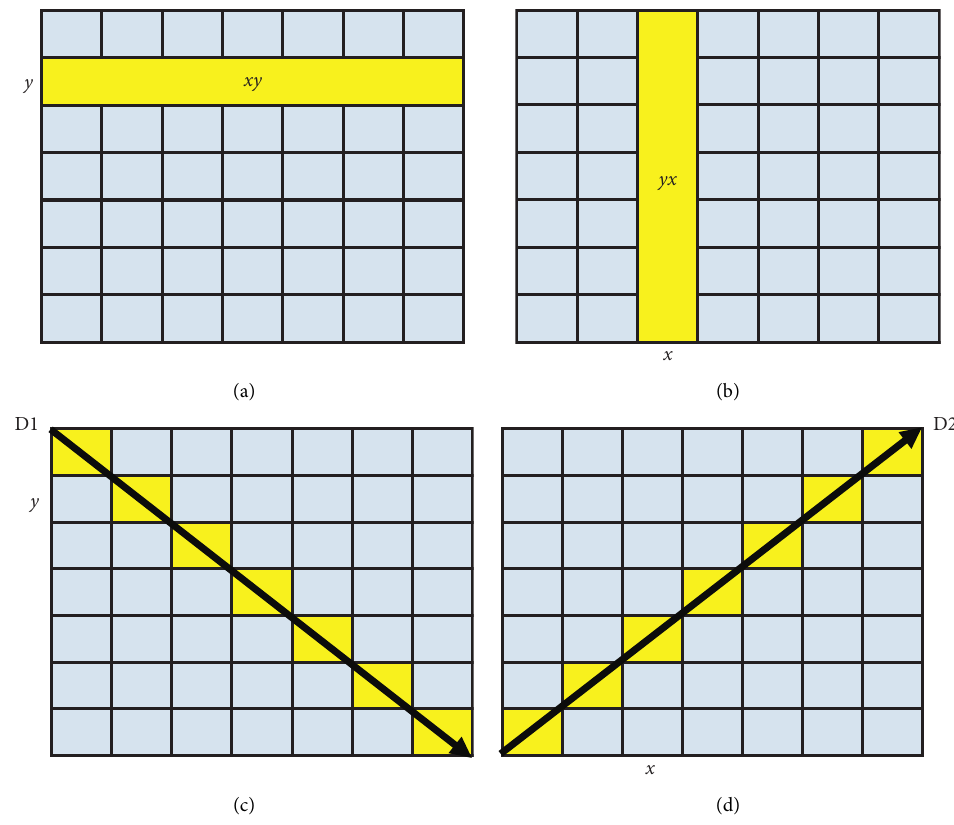
Figure 4: Demonstration of PI calculations. (a) HPI, (b) VPI, (c) DPI